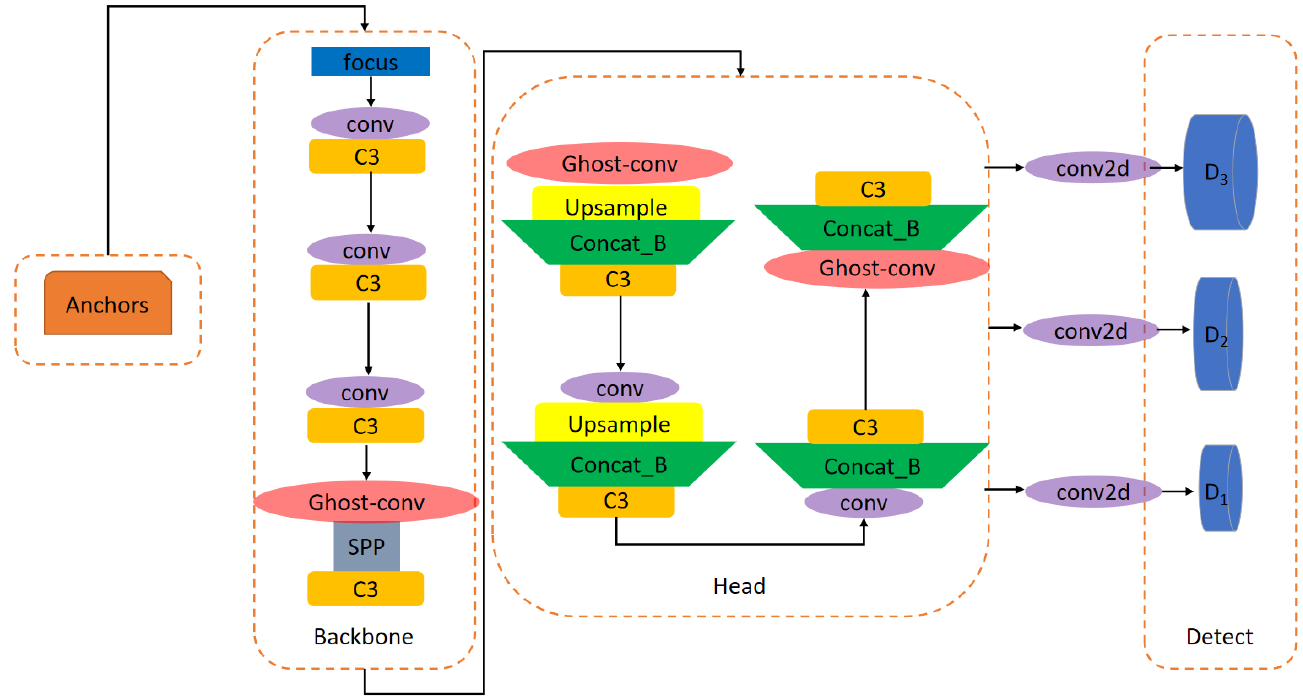
Figure 1. Model E network structure. (The structure is divided into four parts, namely anchors, backbone, head, and detect parts, and the depth of the network is depth_multiple: 0.33, width_multiple: 0.50.)